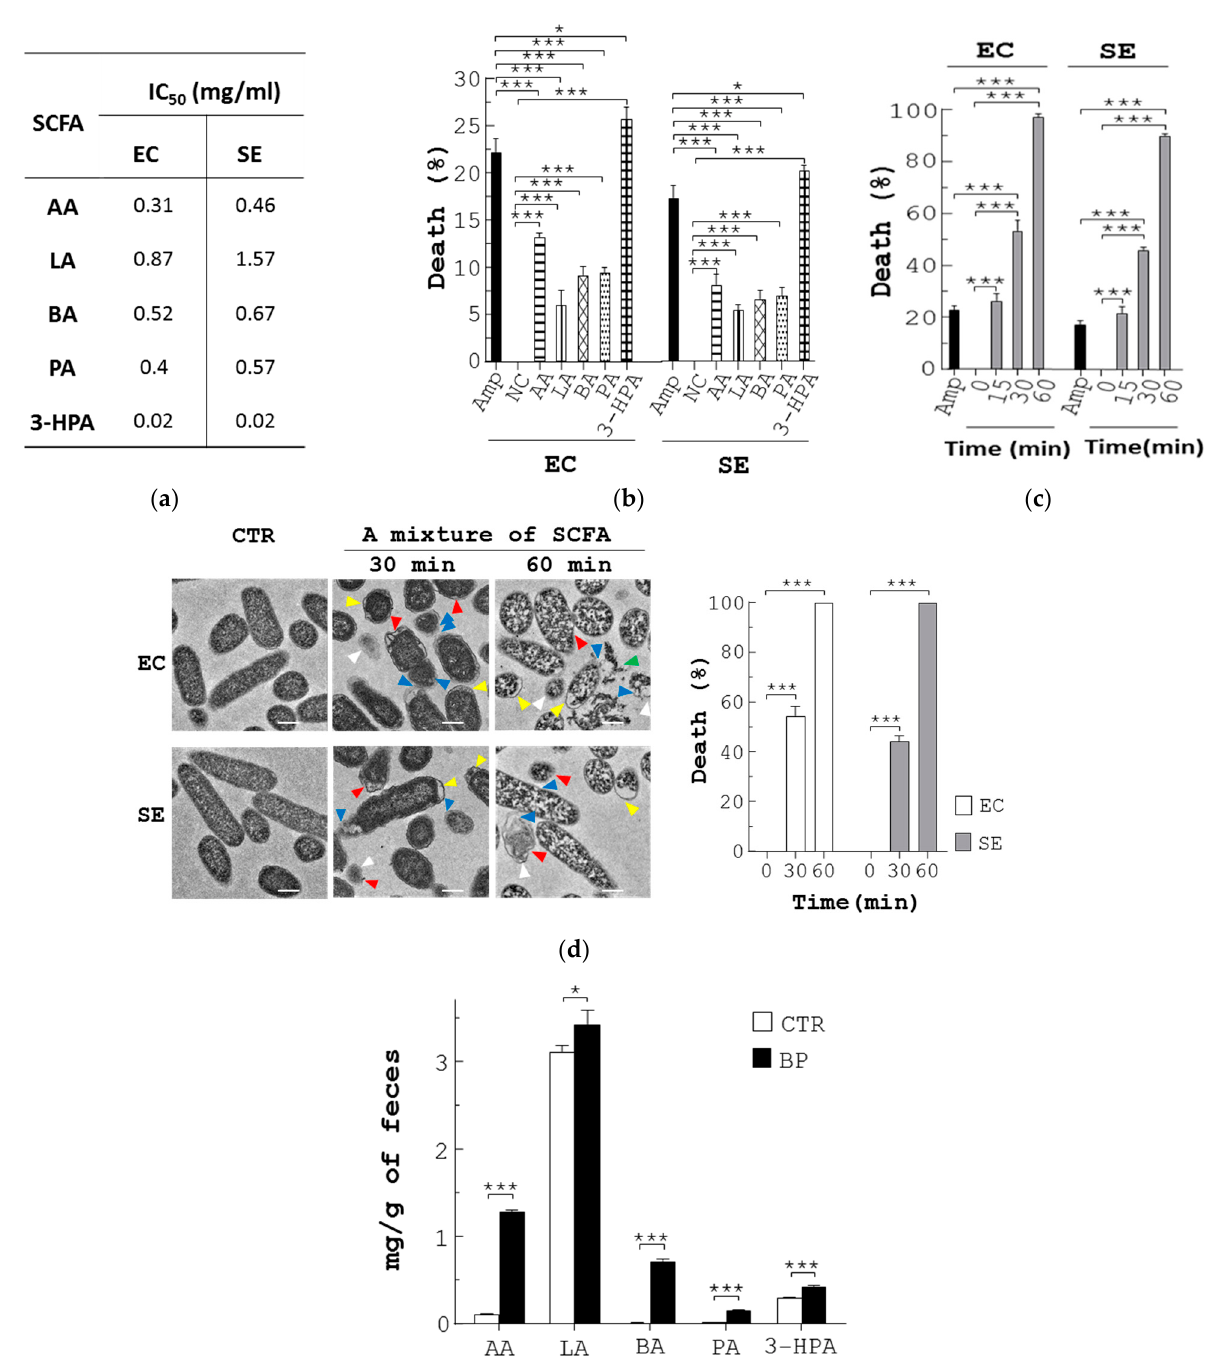
Figure 4. Anti-pathogenic mechanism of SCFA produced from L. reuteri . ( a ) The IC 50 of each SCFA for E. coli (EC) and S. enterica (SE) was determined. ( b ) Each of the pathogens (5 × 10 7 CFU/mL) were grown in LB broth containing vehicle (NC), Amp (30 µg/mL), and each SCFA at its IC 50 dose for 30 min, followed by PI staining. The bacteria were analyzed with flow cytometry to determine the percentage (%) of dead cells. ( c , d ) E. coli (EC) and S. enterica (SE) were treated with Amp and a mixture of the 5 SCFAs at the same doses as those in the feces of BP-fed chickens, for the indicated times. One aliquot of the bacteria was stained with PI and analyzed with flow cytometry to deter- mine the percentage (%) of dead cells ( c ). The other aliquot of E. coli (EC) and S. enterica (SE) was analyzed using TEM. Their representative images are shown (left, d ). Arrowheads in yellow, red, white, and blue indicate separation of the cytoplasmic and outer membranes, distorted outer mem- brane, empty cells, and membrane discontinuity, respectively. Their death (%) was quantified and replotted into histograms (right, d ). Scale bar = 0.5 µm. ( e ) Three-week-old chickens ( n = 3) were fed with standard diet (CTR) and the diet containing 250 ppm BP for 4 weeks. Fecal extracts were sub- jected to LC-MS/MS analysis, followed by quantification of 5 SCFAs (µg/g of feces). Data from 3 repeats are presented as the mean ± SD. One-way ANOVA tests were used for statistical analysis of differences between groups and p (*) < 0.05 and p (***) < 0.001 are considered statistically significant. 3.6. BP Decreases ARG in Fecal Bacteria and Conjugation and Recombination in E. coli To explore the mechanism by which BP decreased AR in fecal bacteria, we first ana- lyzed the composition of genes corresponding to class 1 integrons, implicated in ARG transfer in bacteria, in the fecal microbiome of chickens (Figure S5A). Unexpectedly, a high proportion of the total sequencing reads corresponding to the class 1 integrons, com- posed of 5 ′ -conserved segment (5 ′ -CS), ARG, and 3 ′ -conserved segment (3 ′ -CS), were found in the control fecal microbiome (Total, 5 ′ -CS, ARG, and 3 ′ -CS, CTR, Figure 5a). Con- versely, BP profoundly reduced the proportion of total reads and the elements of the class 1 integrons, suggesting a reduction of ARG by BP (BP, Figure 5a). Next, to study the action of BP on HGT of ARG, we first adopted an interbacterial conjugation and recombination system composed of a donor E. coli strain ( β 2163), harboring pD042 plasmid, and a recip- ient E. coli strain (UB5201), harboring p3938 and p929 plasmids, as published [31]. A co- incubation of donors and recipients in this system generated an HGT frequency of 5.4 arbitrary units (AU) (CTR, Figure 5b). In contrast, BP dose-dependently reduced this fre- quency (BP, Figure 5b). To further pinpoint the action of BP on conjugation and recombi- nation steps, three assay platforms were applied. The first was a conjugation platform composed of a donor E. coli strain (BM21), harboring RP4 plasmid, and a plasmid-free recipient E. coli strain (MG1656 ( Δ dapA (:: frt ) recA − (Tn 10 ))) as published [32]. A co-incuba- tion of donors and recipients in the assays generated a conjugation frequency of 4.2 × 10 − 1 AU (CTR, Figure 5c). In contrast, BP dose-dependently reduced this frequency (BP, Figure 5c). The second platform was a recombination platform composed of a donor plasmid, pD042, and a recipient E. coli strain (UB5201), harboring p3938 and p929 plasmids, as pub- lished [31]. After pD042 was transformed into recipients, the recombination frequency of the recipients in vehicle groups was 23.9 × 10 − 2 AU (CTR, Figure 5d). In contrast, BP dose-